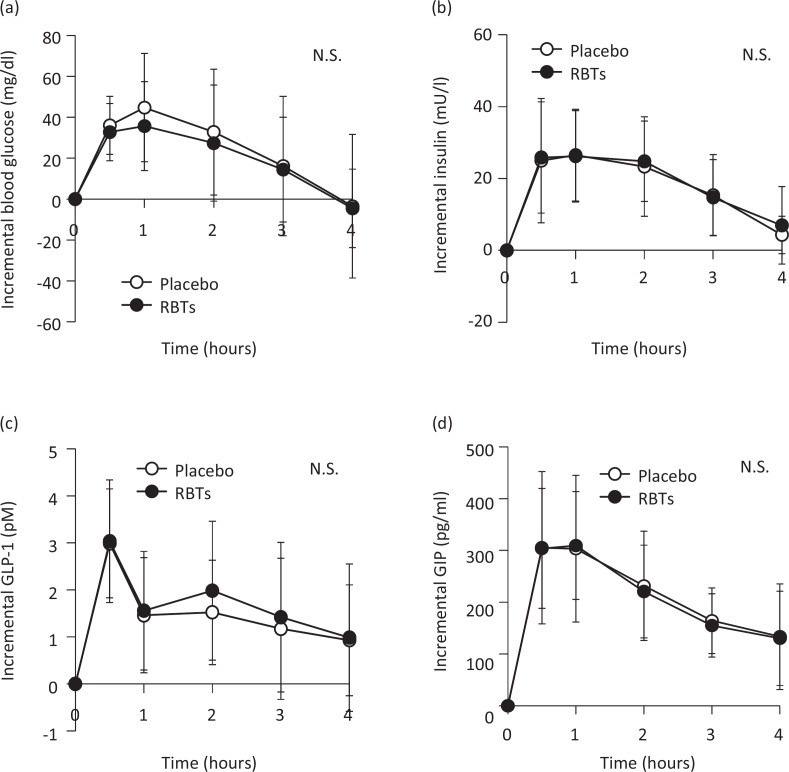
Postprandial changes in blood variables after the consumption of rice bran triterpenoids (RBTs). Blood glucose (a), insulin (b), active glucagon-like peptide-1 (GLP-1) (c), and total glucose-dependent insulinotropic polypeptide (GIP) (d) after the consumption of placebo (○, n = 19) and RBTs (●, n = 19). Data are expressed as means and standard deviations, which are represented by vertical bars. A two-way repeated analysis of variance was used to compare changes over time and between the groups.